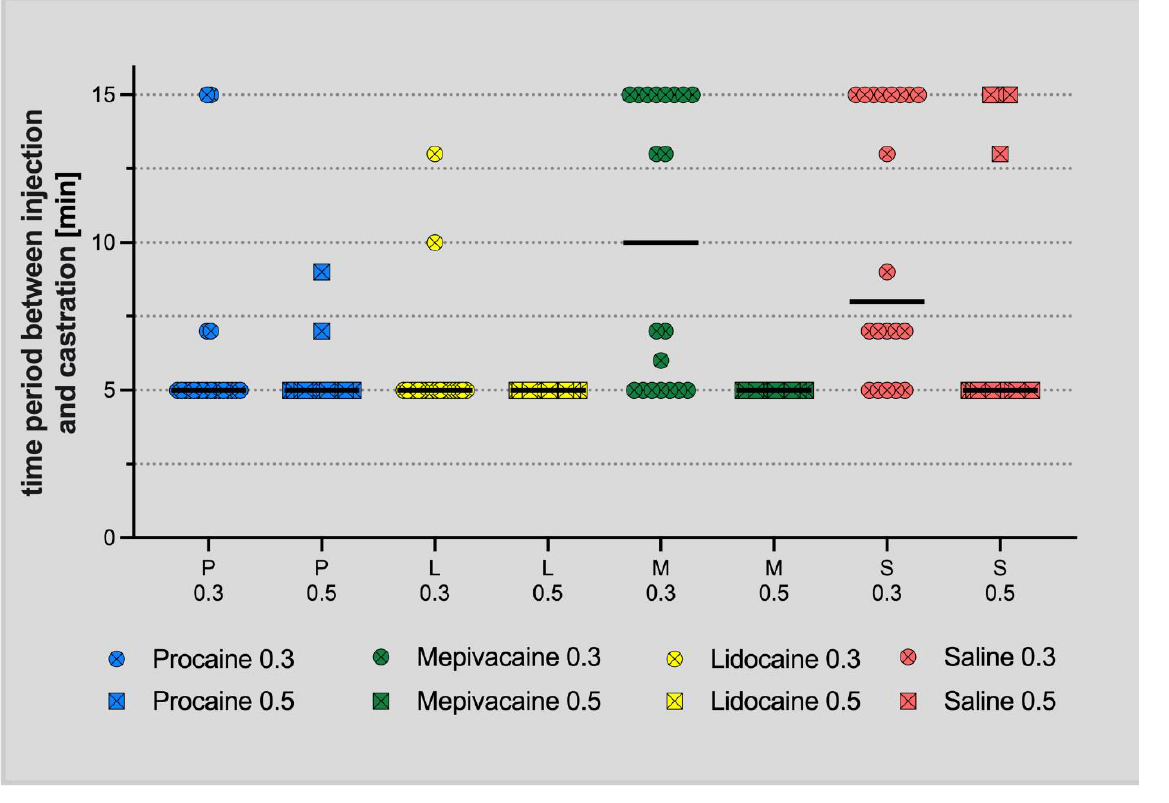
Figure 6. Scatter dot plot of the time period in min between the intratesticular/subscrotal application and castration for groups P 0 . 3 , P 0 . 5 , L 0 . 3 , L 0 . 5 , M 0 . 3 , M 0 . 5 , S 0 . 3 and S 0 . 5 . The black bar represents the median.